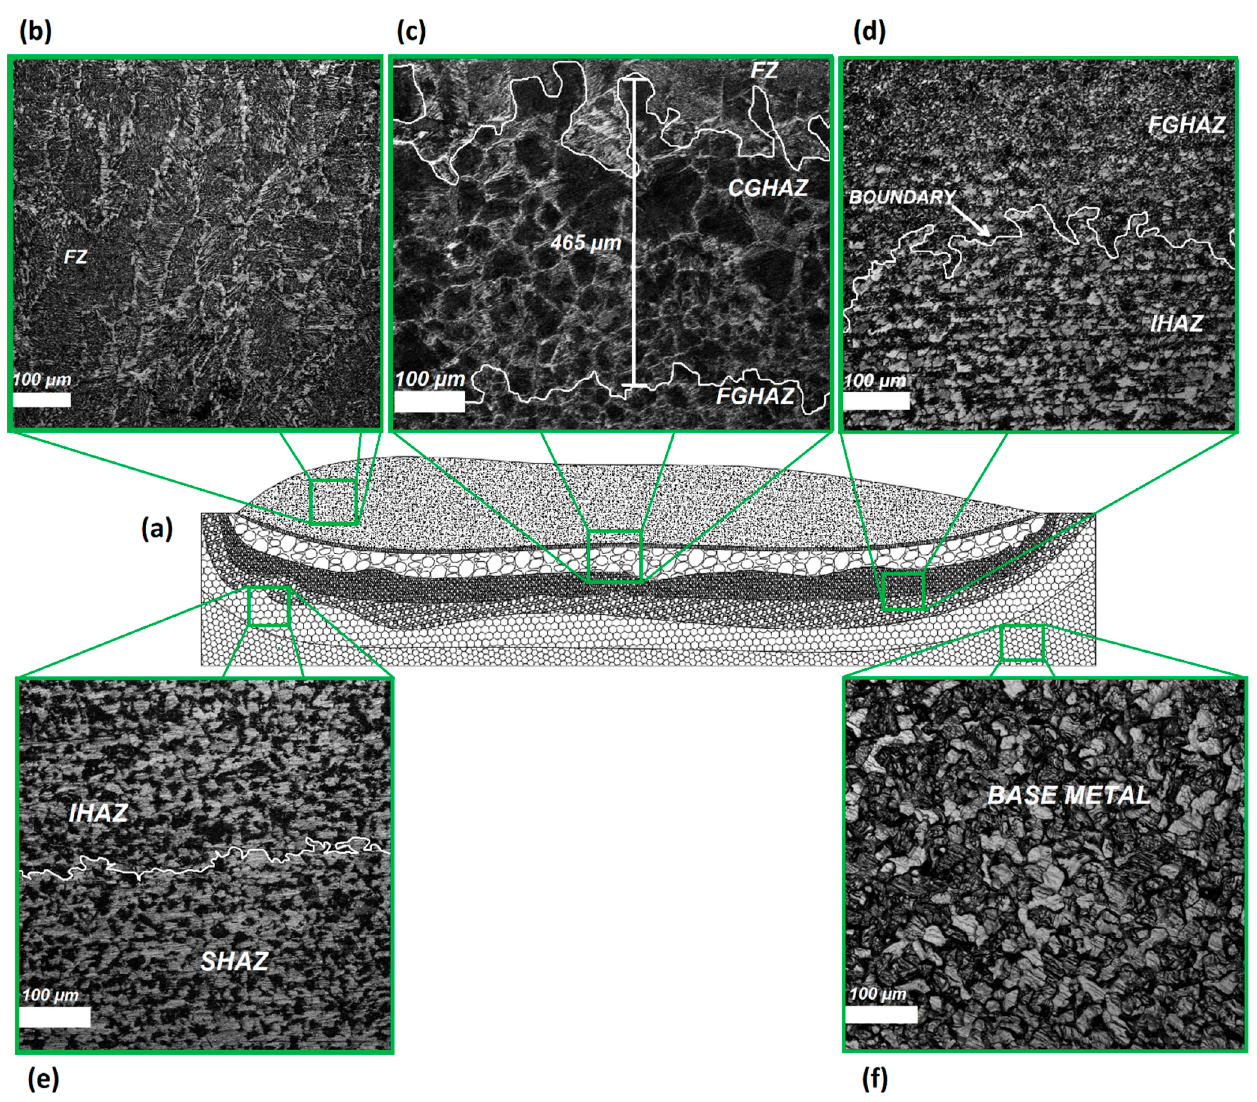
Figure 3. Schematic view of the location of all analyzed zones: ( a ) representation of the longitudinal section of a weld bead; ( b ) FZ; ( c ) FZ, CGHAZ, and FGHAZ boundaries highlighted using image editing tool and CGHAZ extension measurement representation (upper center); ( d ) FGHAZ/IHAZ border highlighted using image editing tool; ( e ) IHAZ/SHAZ border; ( f ) base metal.